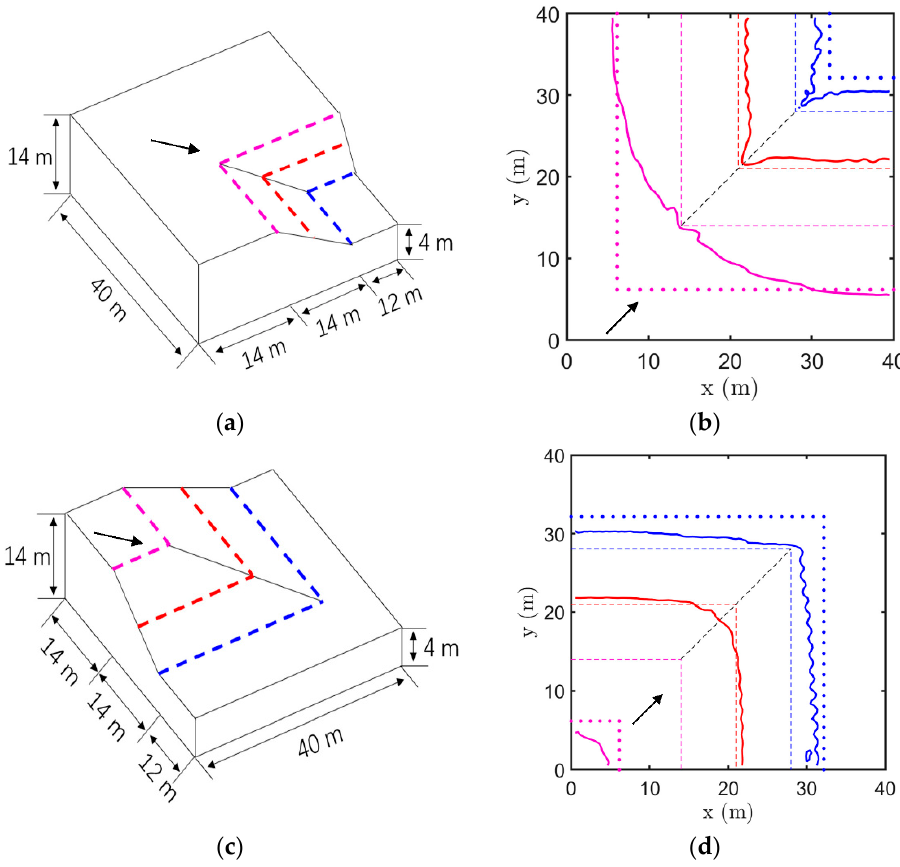
Figure 19. Runout and influence distances of the 3D slopes (dashed lines: initial contours; solid lines: final contours; dotted lines: 2D predictions): ( a ) concave slope shape; ( b ) top view of the final profile of the concave slope; ( c ) convex slope shape; ( d ) top view of the final profile of the convex slope.